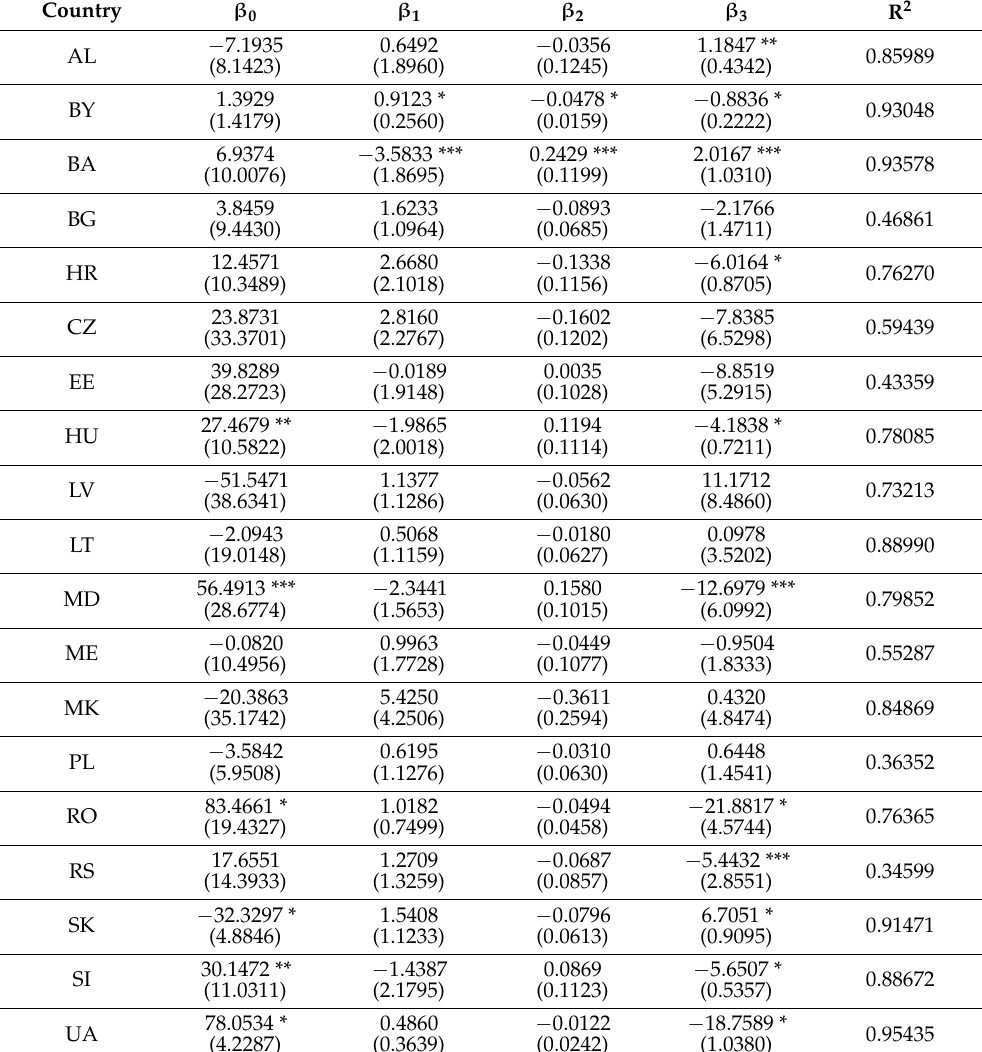
Table 5. Estimation of model parameters for independent variables GPD and